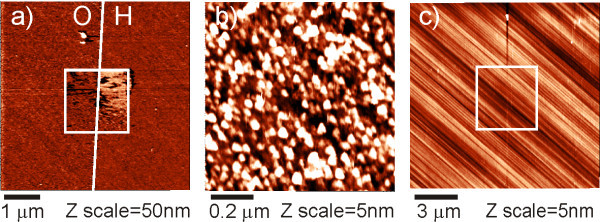
Influence of cantilever spring constant on FBS layer characterization. TM AFM images of fetal bovine serum (FBS) on H/O-terminated monocrystalline diamond (MCD) in solution using cantilevers with different spring constants: (a) by CSG01 cantilever, NT-MDT, k = 0.06 N/m. Central area was scanned in CM (nanoshaving) across H/O-terminated diamond, the position of the boundary was determined using topography data from a large area 135 × 135 μm2 scan, actual scan size is 10 × 10 μm2, A0 ~ 300 nm, energy of cantilever oscillations E ~ kA2/2 ~ 10-15 J; (b) on O-diamond by Multi75Al cantilever, Budget Sensors, k = 3 N/m, scan size 1 × 1 μm2, A0 ~ 50 nm, E ~ 10-14 J; (c) on O-diamond by NaDiaProbes, ADT, k = 120 N/m, scan size 15 × 15 μm2, A0 ~ 50 nm, E ~ 10-13 J, proteins were removed from the central area of 5 × 5 μm2 by CM scan prior to TM.